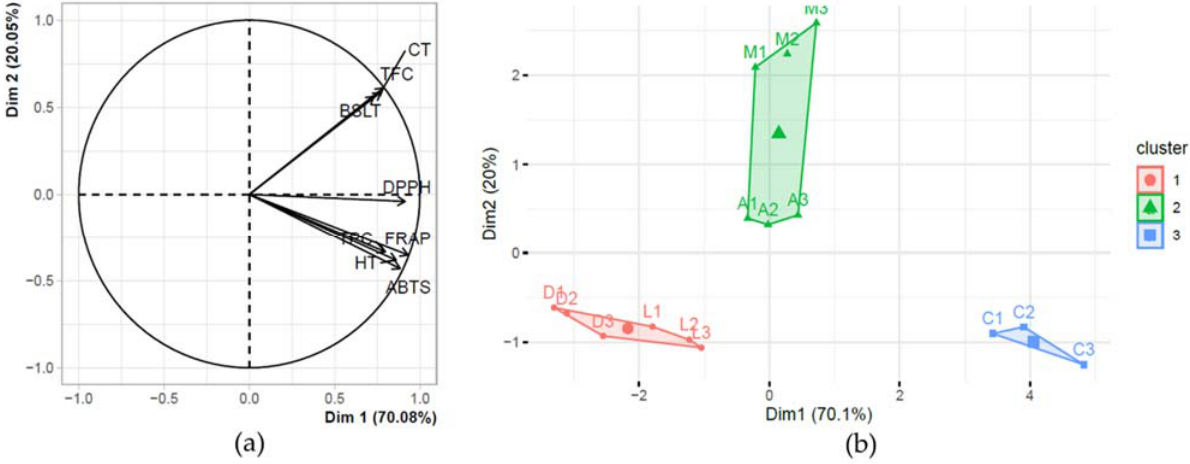
Figure 2. Results of principal component analysis followed by cluster analysis: ( a ) loading plot of pharmacological and phytochemical parameters; ( b ) score plot and clusters of the five Acacia heartwood extracts defined on the basis of pharmacological and phytochemical parameters.